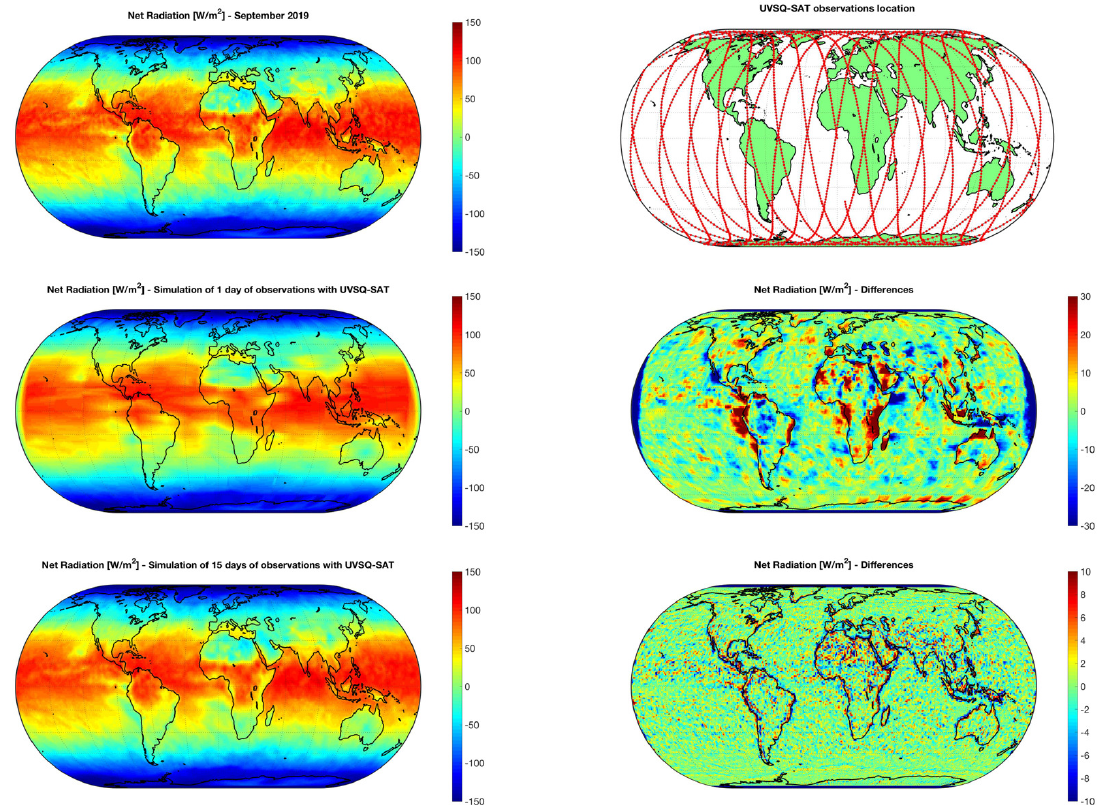
Figure 6. Spatial reconstruction of Earth’s net radiation binned into a 1 ◦ × 1 ◦ latitude-longitude geographic grid that will be obtained with UVSQ-SAT. The source of data for the left upper panel was from CERES